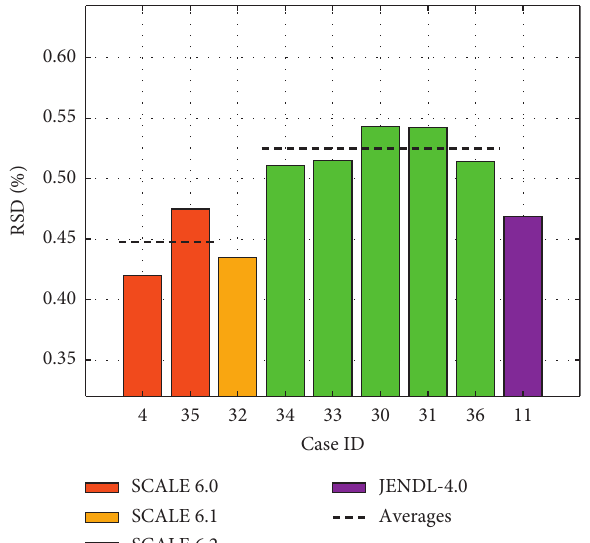
Figure 10: RSD of predicted k -eff of TMI-1 core simulation at HZP.